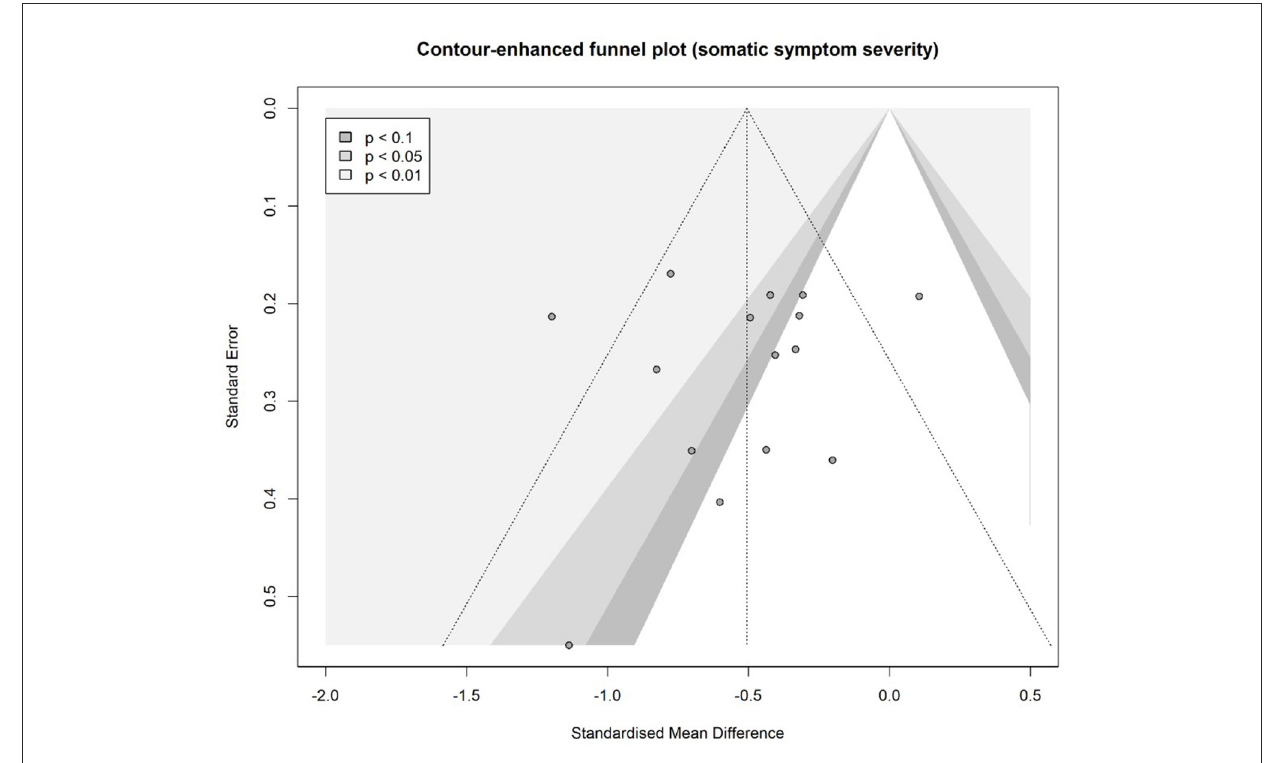
FIGURE3 Contour-enhanced funnel plot for somatic symptom severity